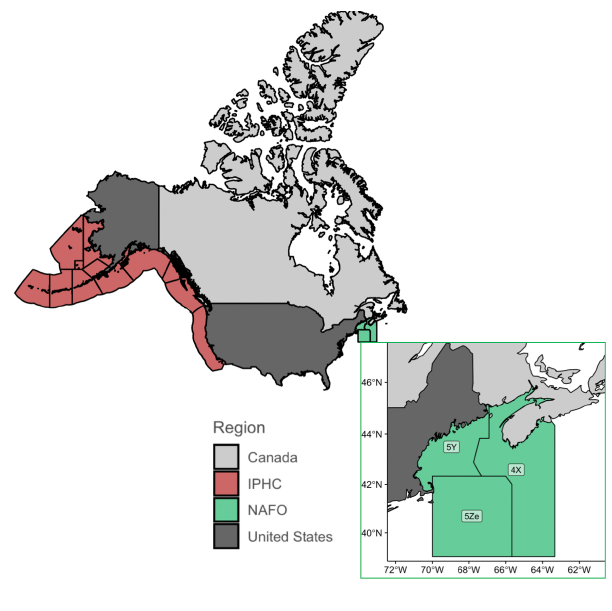
Fig. 1 . Study area. The International Pacific Halibut Commission (IPHC) management area is in red and the Northwest Atlantic Fisheries Organization (NAFO) areas within the Gulf of Maine are represented in